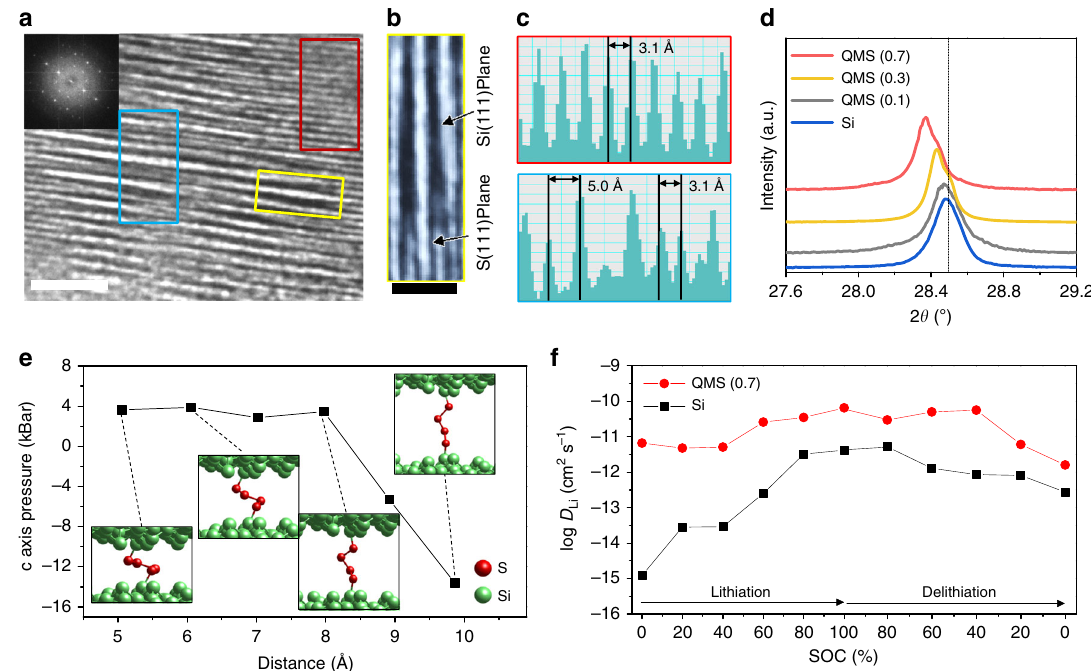
Fig. 3 Sulfur-fusion-induced channel formation in quasi-metallic silicon. a HR-TEM image of QMS (inset: corresponding fast fourier transform image). b Enlarged TEM image showing column formation between characteristic Si (111) planes. c Intensity pro fi les of selected areas in ( a ). d XRD patterns of Si and a series of QMS between 27.6 – 29.2°. e Sulfur chain structure under applied pressure depending on different channel sizes, as calculated by DFT. f Li-ion diffusion coef fi cient versus the state of charge (SOC) during the fi rst cycle. Scale bars, 2 nm ( a ); 1 nm ( b